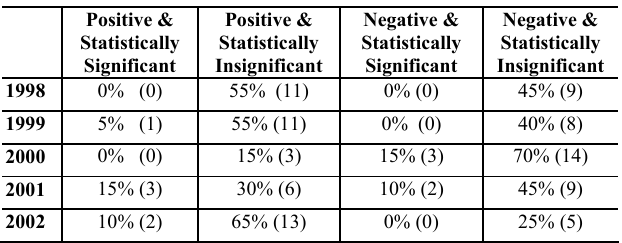
Table 1: CAPM results according to alpha values Positive &